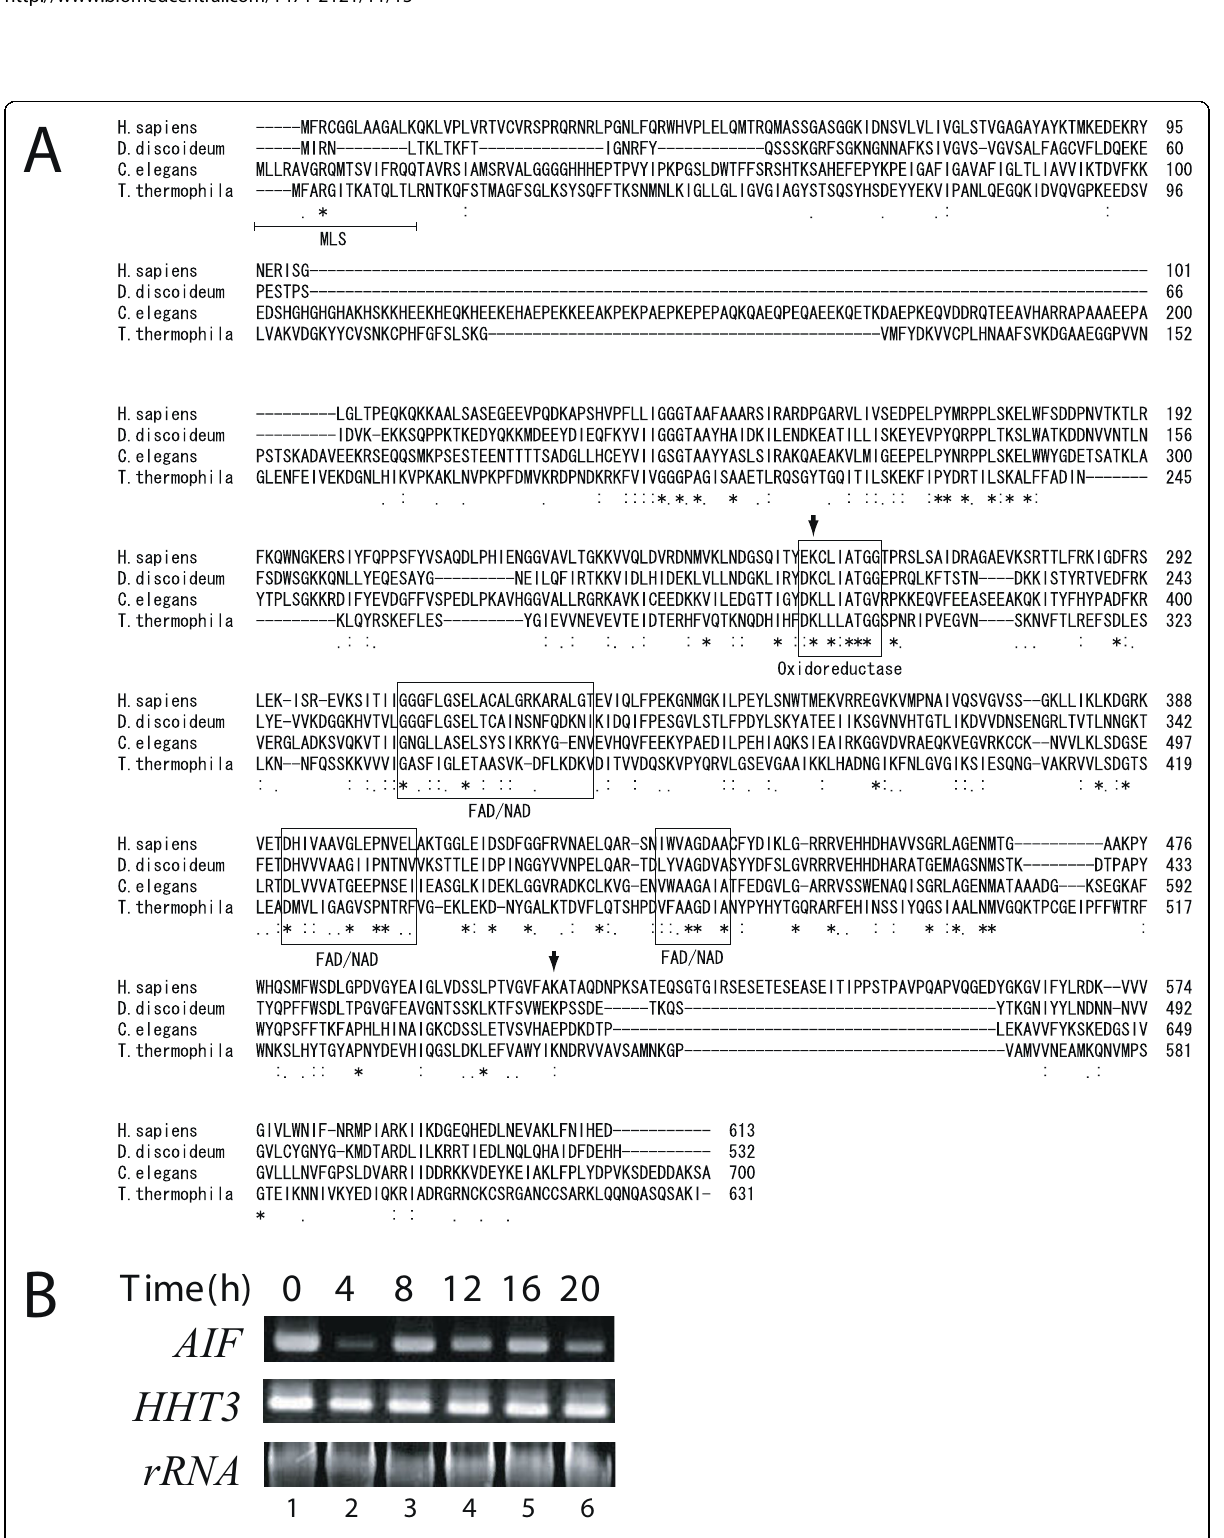
Figure 2 Sequence alignment of AIF proteins and analysis of AIF expression . A. CLUSTAL-W was used to generate AIF sequence alignment, including Homo sapiens , Dictyostelium discoideum , Caenorhabditis elegans and Tetrahymena thermophila . Boxes indicate the NAD/FAD binding domain and oxidoreductase domain. MLS in N-terminal portion of T.thermohila indicates mitochondrial localization sequence. Asterisks indicate identical amino acids. Colons and semicolons indicate amino acid similarity. Arrowheads indicate a potential DNA binding site of human AIF. B. RT-PCR analysis of AIF transcript during conjugation. Histone h3 ( HHT3 ) was used as a control. SSU rRNA was used as a loading